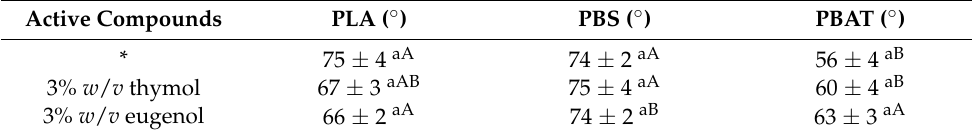
Table 3. Contact angles values for tested polymer films. Active